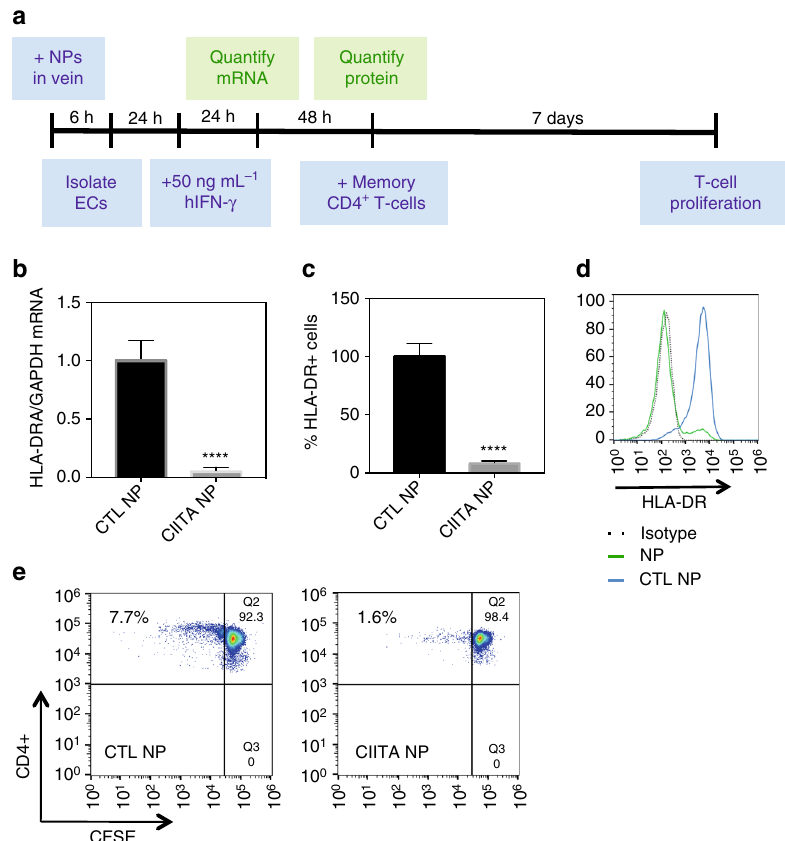
Fig. 5 NP perfusion reduces CD4 + memory T-cell proliferation. a CD4 + memory T-cell proliferation. Umbilical veins were perfused with culture medium containing siRNA-loaded NPs (0.1 mg mL − 1 ) or CTL siRNA-loaded NPs (0.1 mg mL − 1 ). After 6 h, ECs were harvested from veins and seeded into 24-well plates. CFSE-labeled CD4 + memory T cells were co-cultured with endothelial cells for 7 days. T-cell proliferation was then quanti fi ed using fl ow cytometry b HLA-DRA/GAPDH mRNA was quanti fi ed 24 h after addition of hIFN- γ by quantitative reverse transcription-PCR. c , d HLA-DR protein was quanti fi ed by fl ow cytometry. e CD4 + memory T-cell proliferation was determined by CFSE dye dilution on fl ow cytometry. Data shown is mean ±